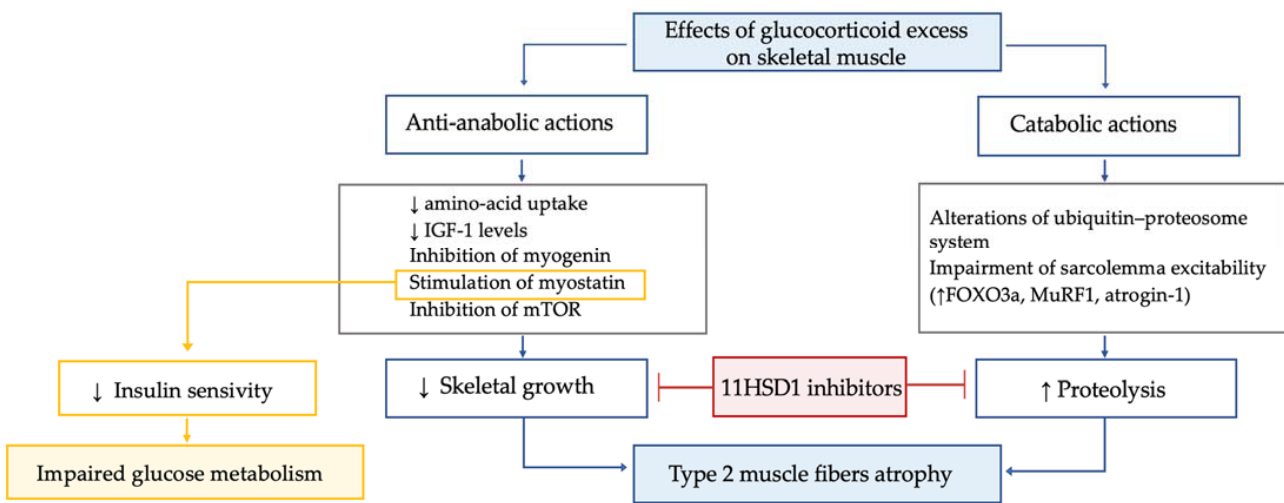
Figure 5. Effects of glucocorticoid excess on skeletal muscle tissue.